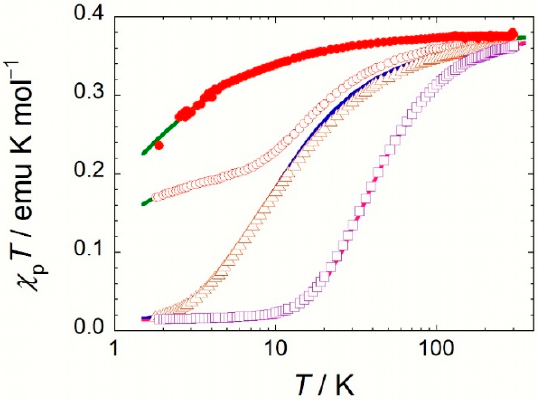
Figure 5. Temperature dependences of χ p T of 2-FNN (open circles), 3-FNN (open triangles), 2-BFNN (open squares), and 2-FIN (closed circles). The solid lines represent fits using the four-spin linear tetramer model for 2-FNN, the 1D alternating AFM Heisenberg model for 3-FNN and 2-BFNN, and the Curie–Weiss law for 2-FIN (see the text).